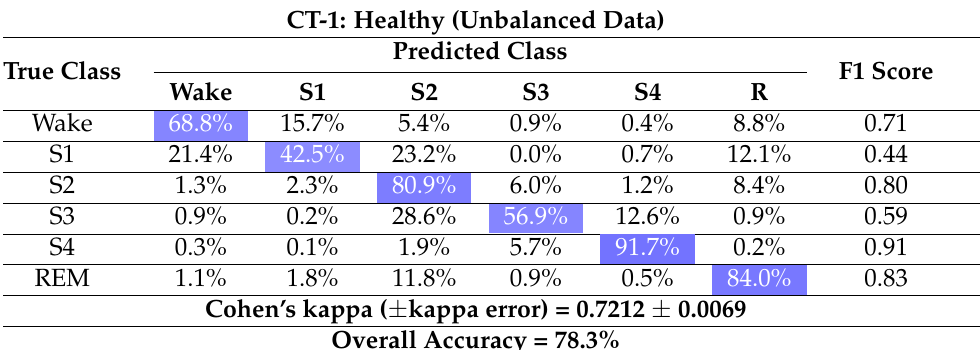
Table 9. Confusion matrix corresponding to sleep stage classification of healthy subjects with unbalanced data using the EBT classifier with 10-fold